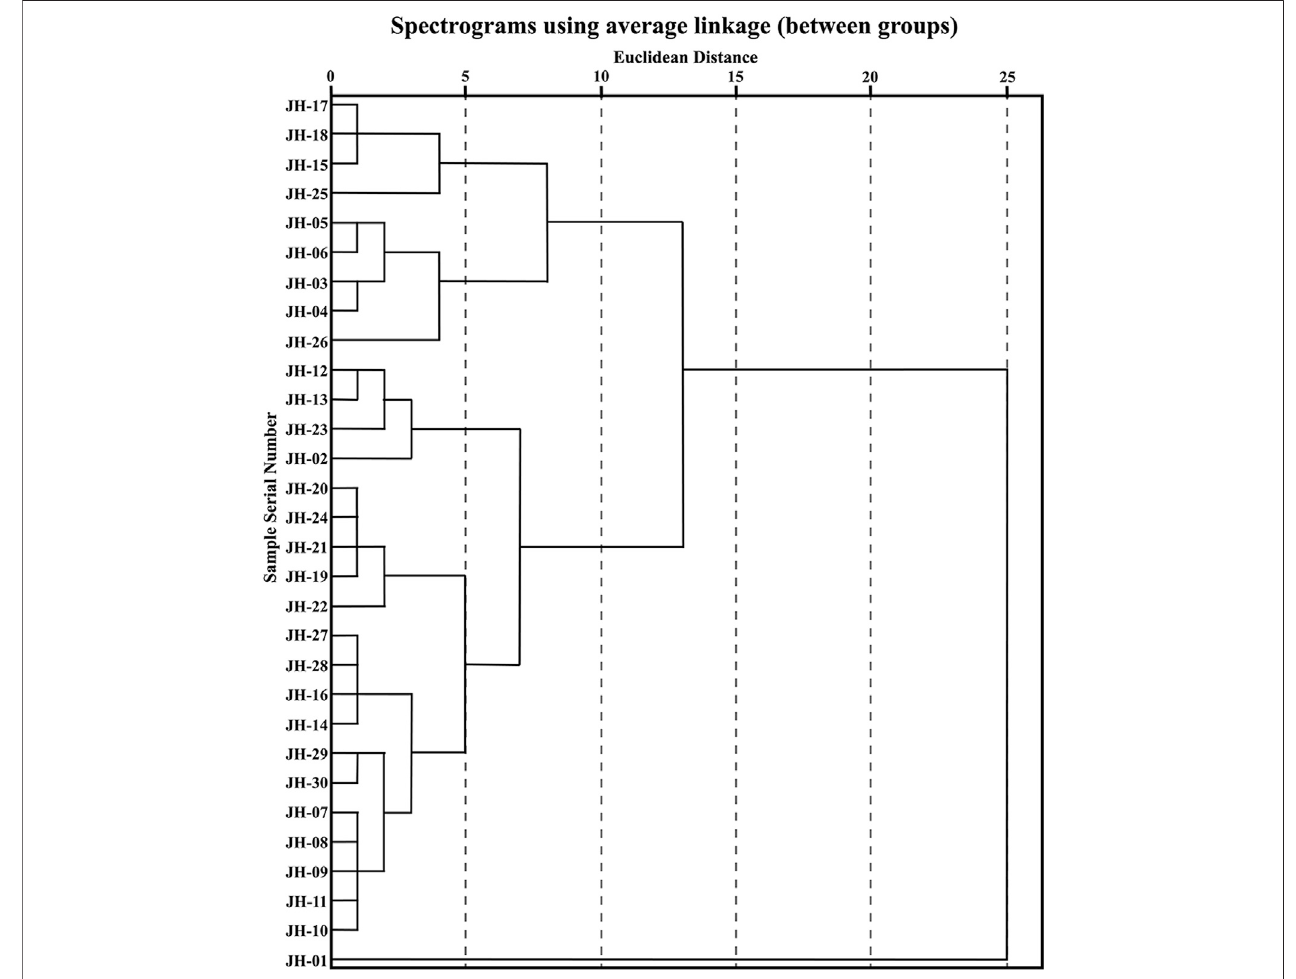
FIGURE 2 | Phylogenetic cluster analysis of 30 fl ower head samples of CMs.